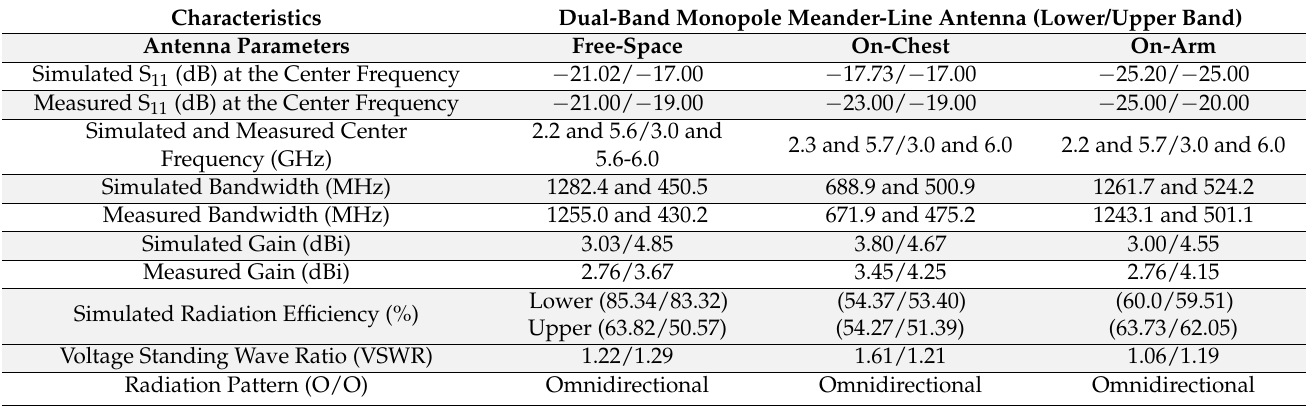
Table 3. Summary of the antenna’s performance